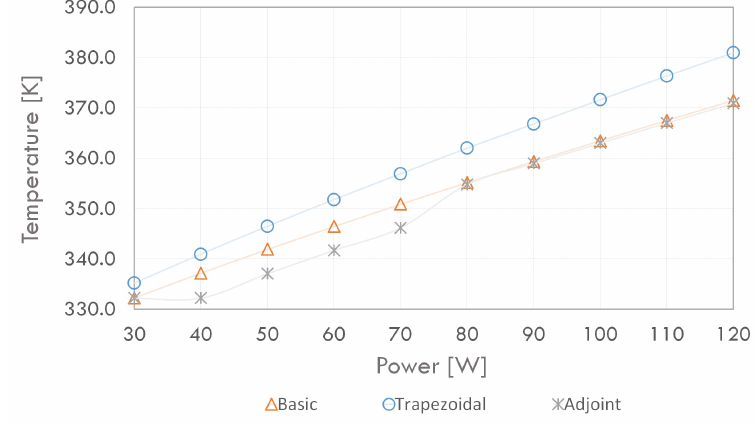
Figure 27. Temperature dependence of the heat source versus heat flux.